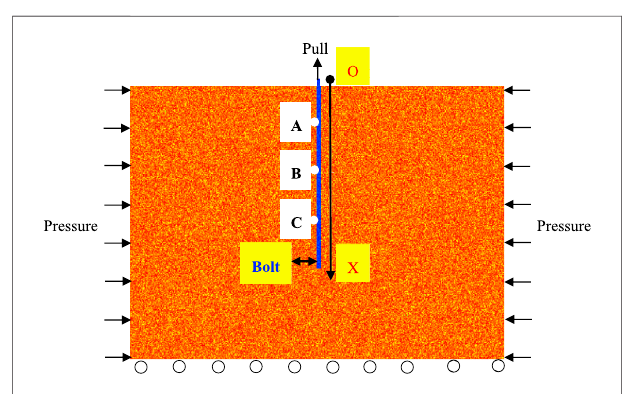
FIGURE 4 | Numerical model.